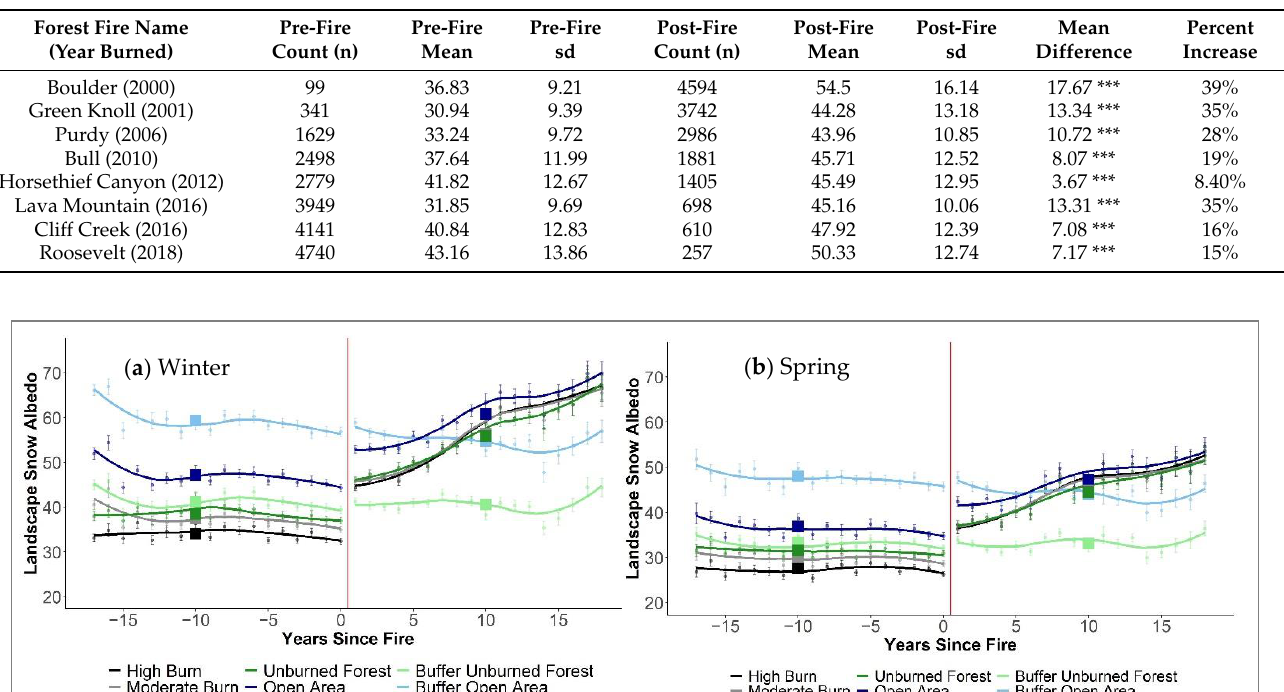
Table 2. Pre-fire and post-fire LSA statistics for all eight separate fires, including Pre-fire count (n) of MODIS cells used in the analysis, pre-fire mean LSA, pre-fire standard deviation (sd) of LSA, post-fire count (n) of MODIS cells used in the analysis, post-fire mean LSA, post-fire standard deviation (sd) of LSA, the mean difference, and post-fire total percent increase for each fire. The sample size was determined by the number of cloudless (50% or less) MODIS scenes available since 2000 relative to the year the fire occurred. The significance reported with the mean difference was calculated using Welch’s two-sample t -test, *** = p -value < 0.001.